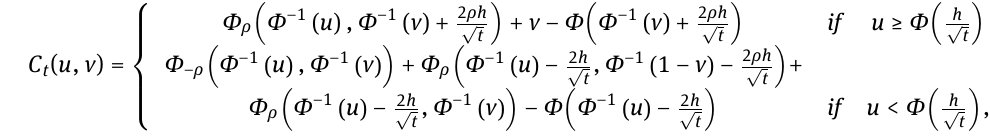
− B 2 at time t = 1 and t = 20 with h = 0.25 and ρ = 0.9. The t t